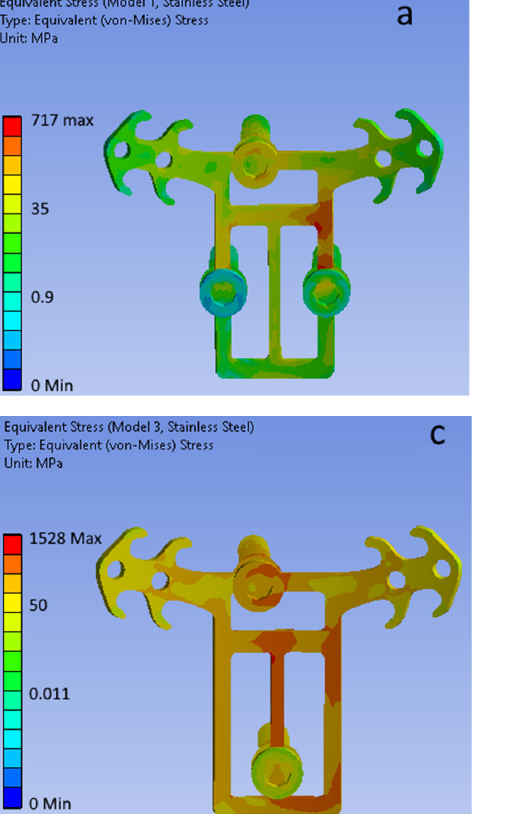
Figure 8. Total displacement fields for ( a )–( d ) mini-implant configurations (POD material—stainless steel). ( a ) Model 1. ( b ) Model 2. ( c ) Model 3. ( d ) Model 4.